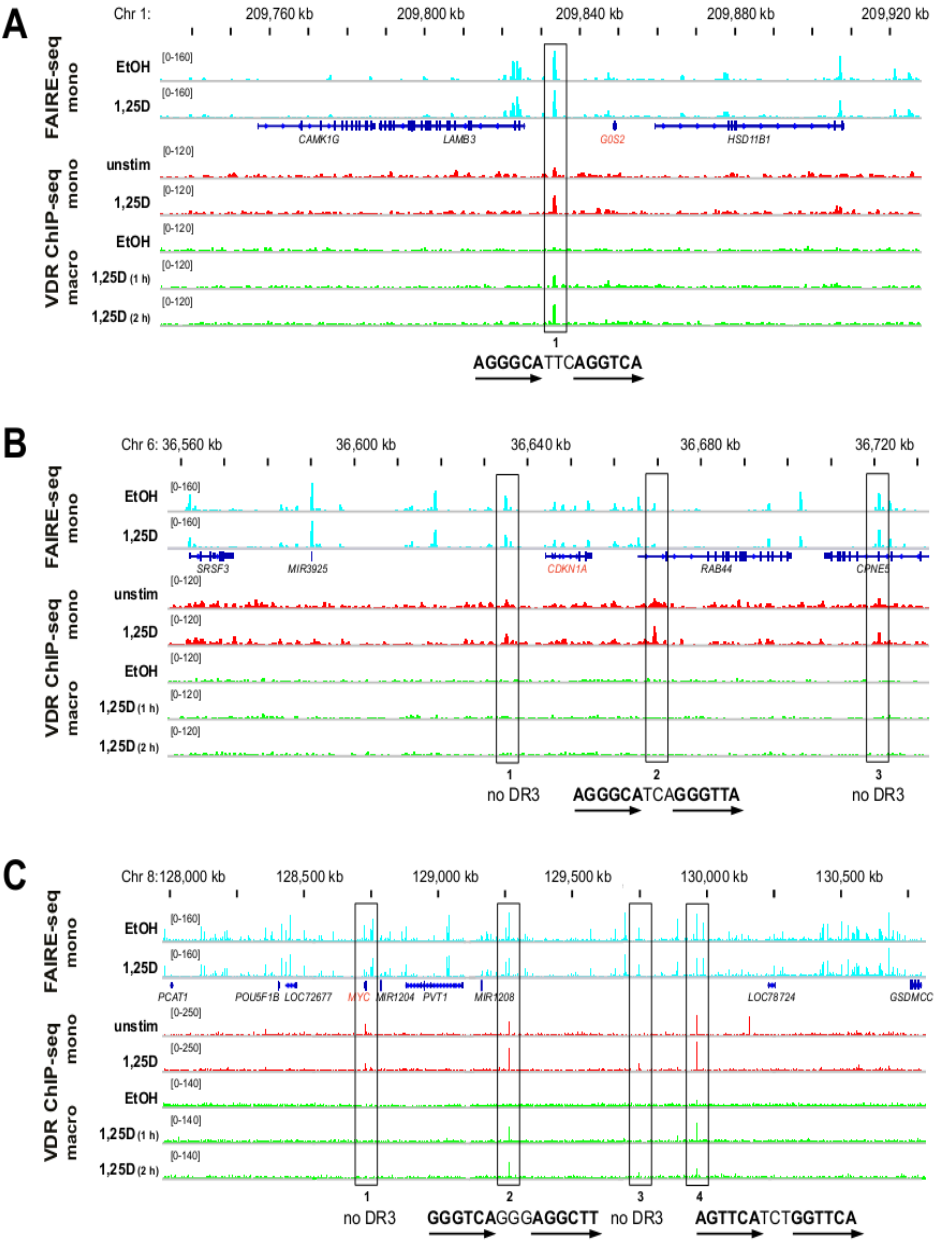
Figure 2. 1,25(OH) D -dependent chromatin opening and VDR association in monocyte- 2 3 and macrophage-like cells. The IGV browser was used to display the VDR peaks of the chromosomal domains (see Supplementary Figure S3) of the genes G0S2. ( A ) CDKN1A ( B ) and MYC ( C ). The peak tracks show FAIRE-seq data obtained from monocyte-like cells (mono, undifferentiated THP-1 cells, treated for 100 min with EtOH or 1,25(OH) D 2 3 (1,25D), light blue [34]) in comparison to VDR ChIP-seq data from monocyte-like cells (undifferentiated THP-1 cells, without or with 1,25(OH) D treatment for 40 min, red [4]) 2 3 and from macrophage-like cells (macro, PMA-differentiated THP-1 cells, treated with EtOH or 1,25(OH) D for 1 and 2 h, green). The gene structures are shown in blue. 2 3 Investigated VDR peak regions are boxed. The sequences of the DR3-type VDR binding sites below the summits of the peaks are indicated (arrows indicate the hexameric nuclear receptor binding sites); some peaks carry no DR3-type